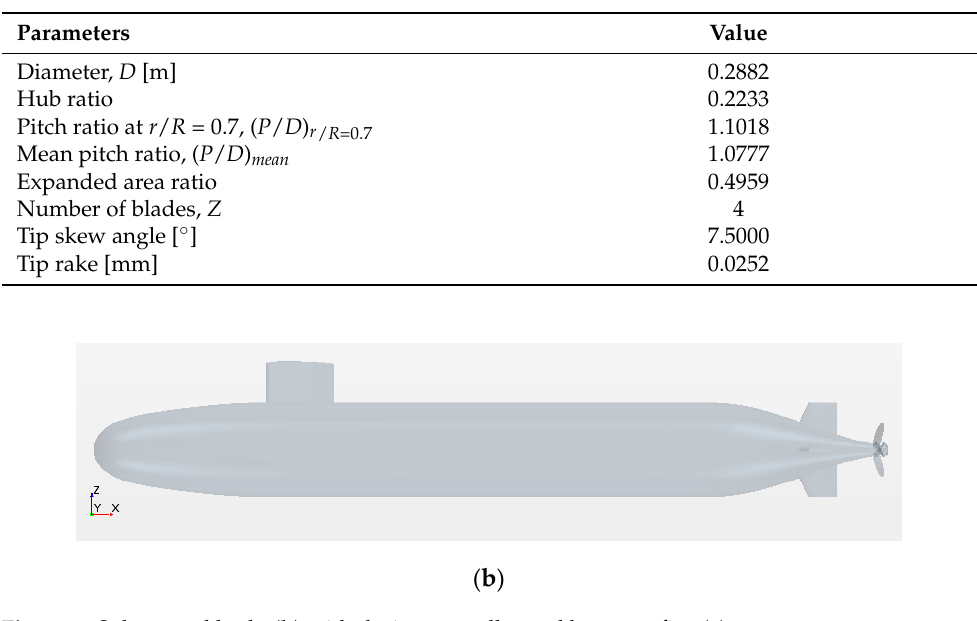
Figure 1. Submerged body ( b ) with design propeller and boss cap fins ( a ).